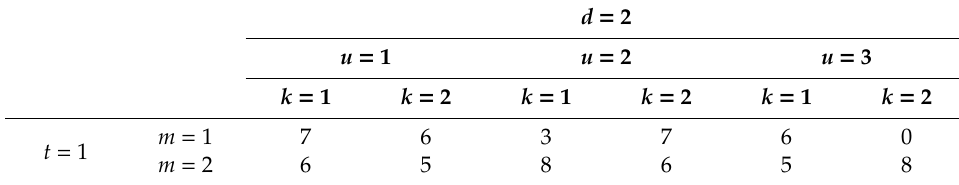
Table 23. Required number of each vehicle between manufacturers and distributor in period t = 1.